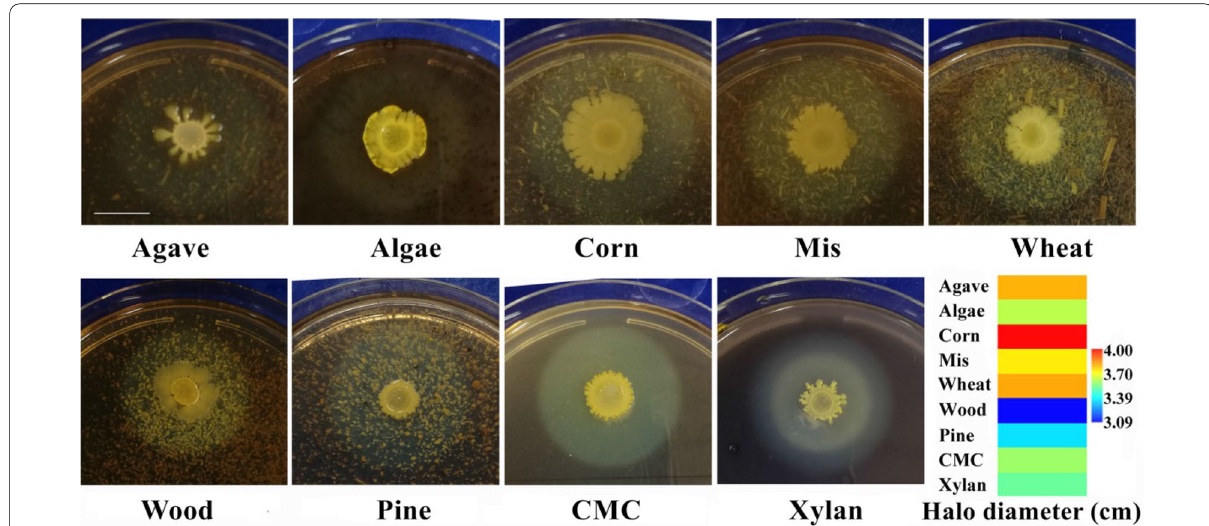
Fig. 1 The halo diameters (cm) were produced by of Bacillus sp. P3 using on MMS agar medium supplemented with 0.5% different biomasses. The hydrolysis abilities exhibited by the strain P3 were compared by matrix